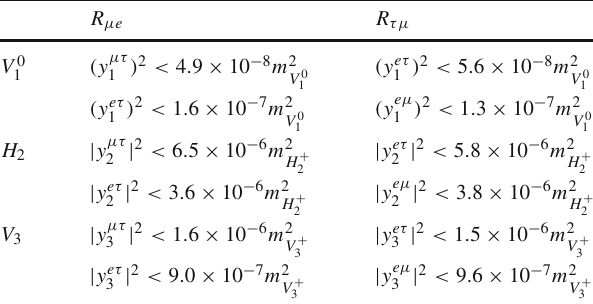
Table 1 The constraints on the CLFV couplings in units of GeV − 2 from the lepton flavor universality of leptonic τ decays. The constraints on V 0 are from the interference with the SM and thus 1